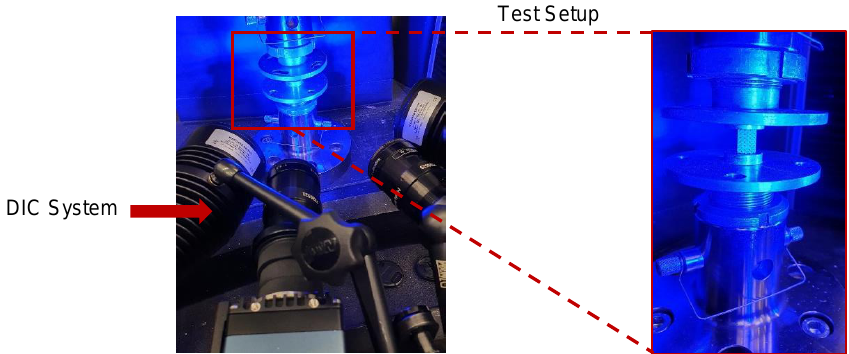
Figure 6. Experimental setup for compression tests on AM Zn1Mg scaffolds.